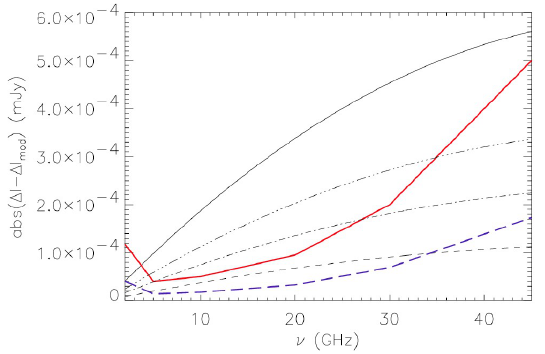
Figure 7: Difference between the standard thermal SZE calculated for A2163 in 2–45 GHz range and in- tegrated in a 1 arcmin 2 area and the one modified for values E ∗ = 5 × 10 − 9 eV (solid line), 3 × 10 − 9 eV (dash - 3 dots), 2 × 10 − 9 eV (dot-dashed), and 1 × 10 − 9 eV (dashed). The sensitivity achievable with SKA in ∼ 30 hours (red thick solid line) and in ∼ 260 hours (blue thick long-dashed line) are shown